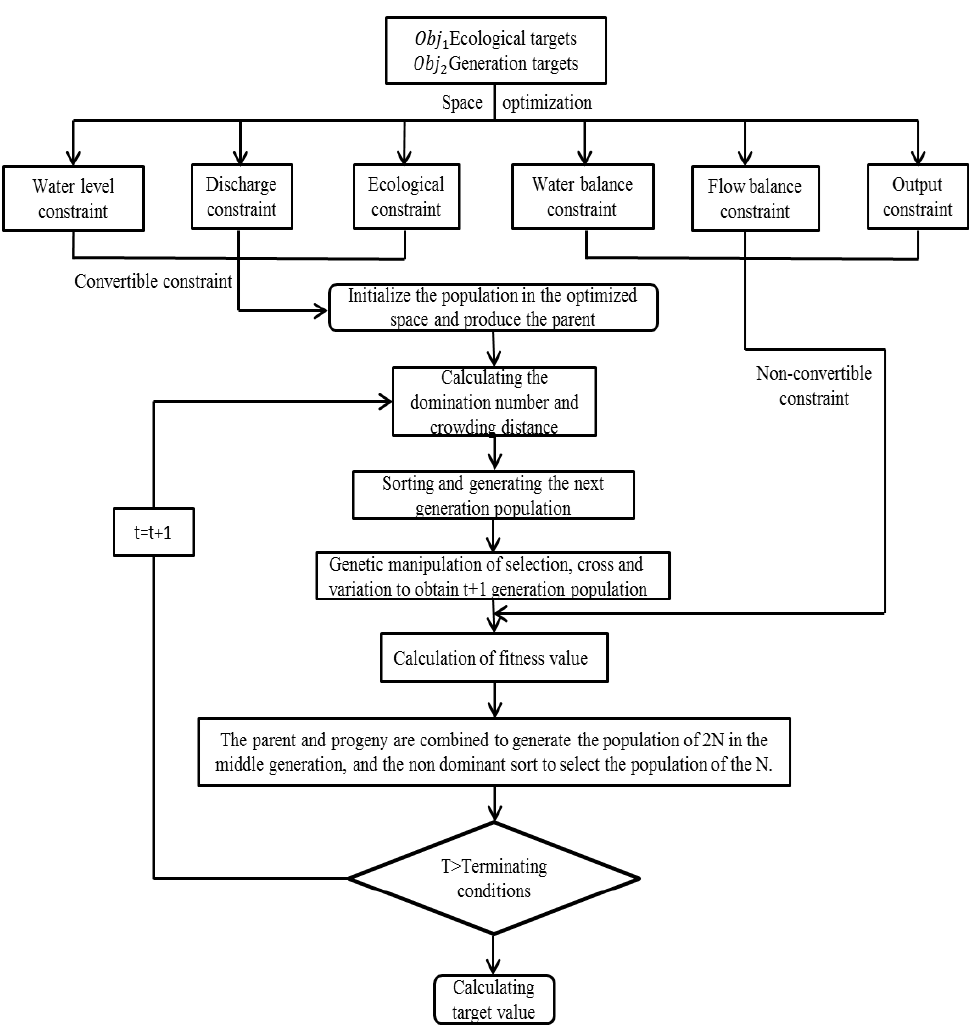
Figure 5. The operation flow chart of the non-dominated genetic algorithm (NSGA-II).